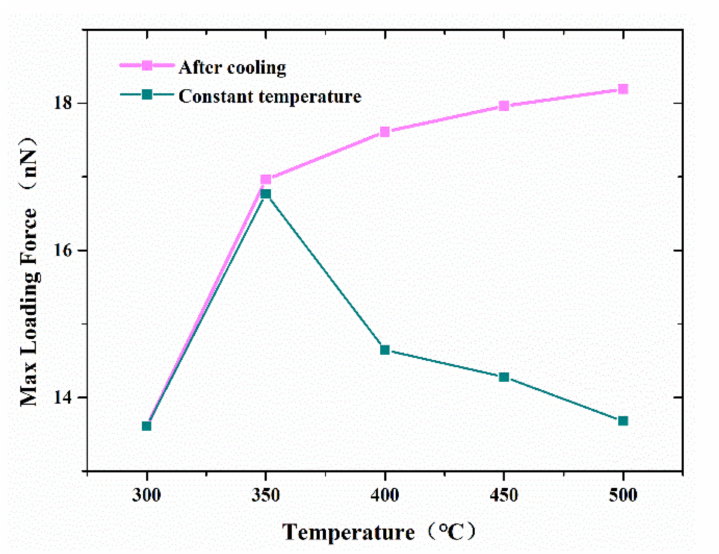
Figure 9. Effect of temperature on the strength of the formed joints between two cones.